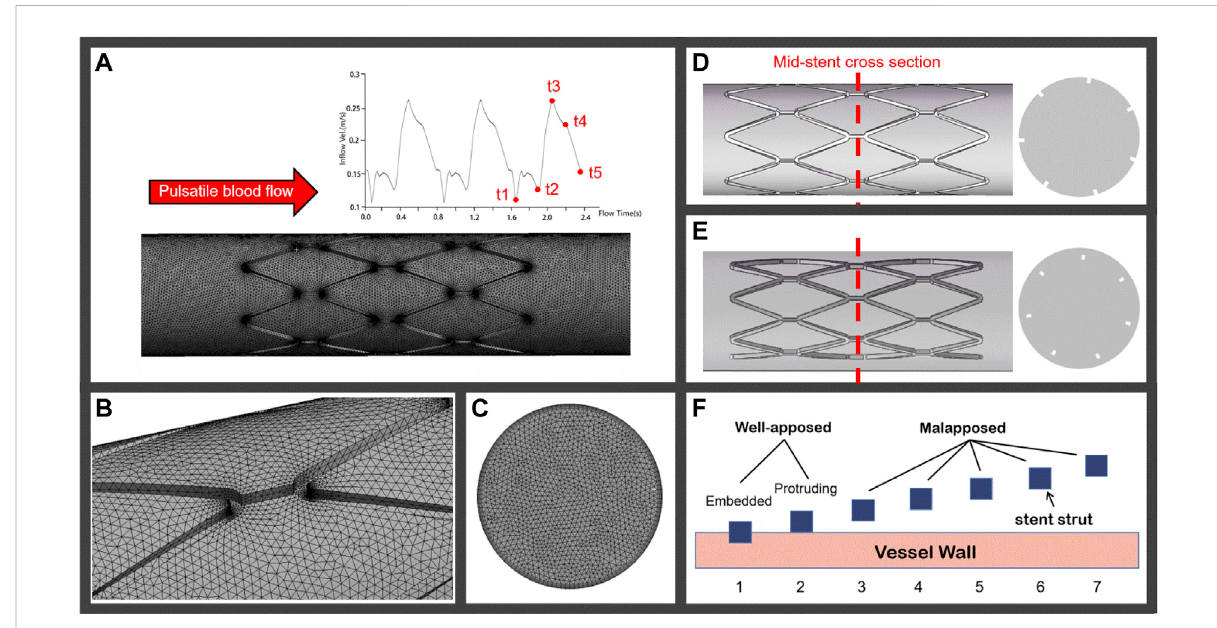
ranging from 75 μ m (Case 3) and 225 μ m (Case 5) to 400 μ m